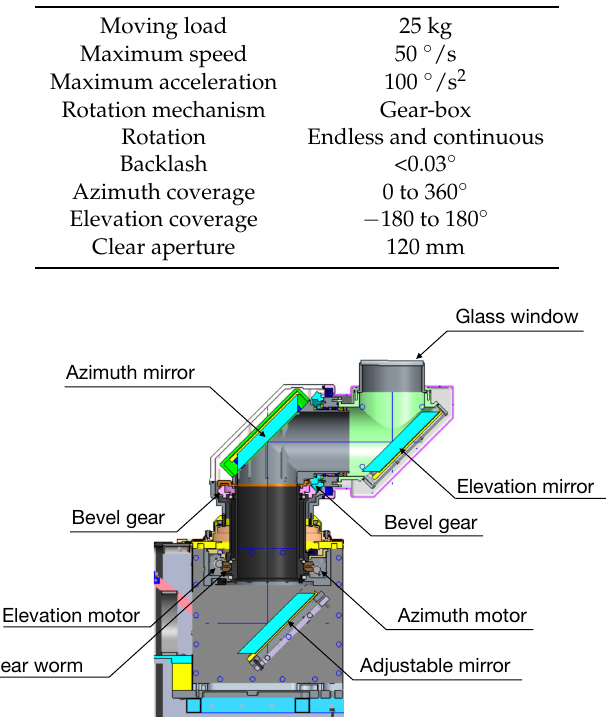
Figure 3. The scanner head vertical